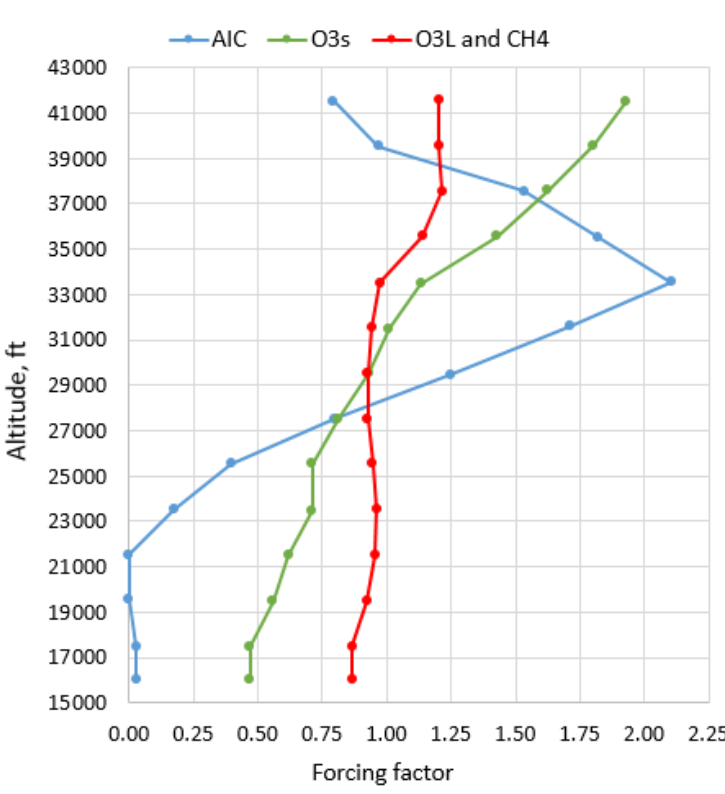
Figure 12. Forcing factor as a function of altitude